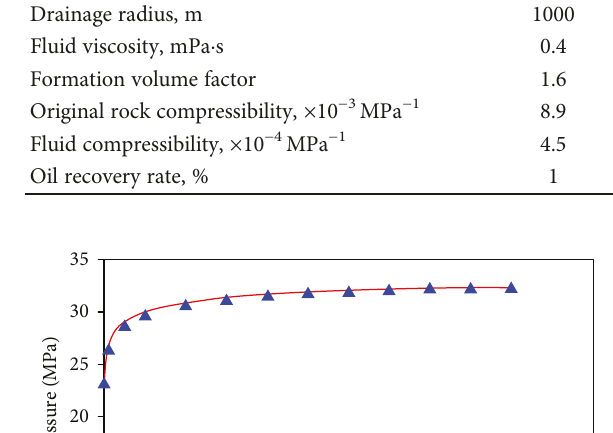
Figure 6: Energy supplement time vs original rock compressibility.